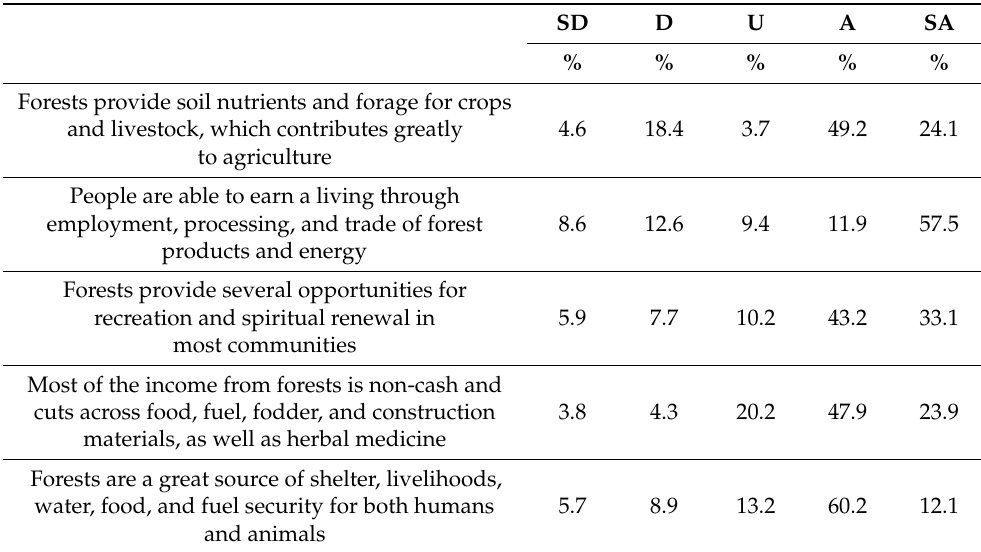
Table 5. Results of indirect income from